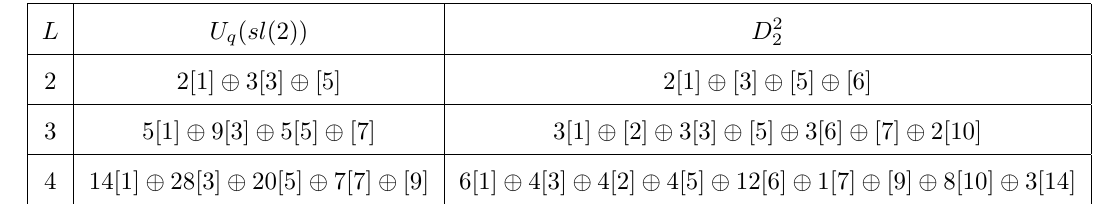
Table 4 . The degeneracies of the D 2 U q ( sl (2))